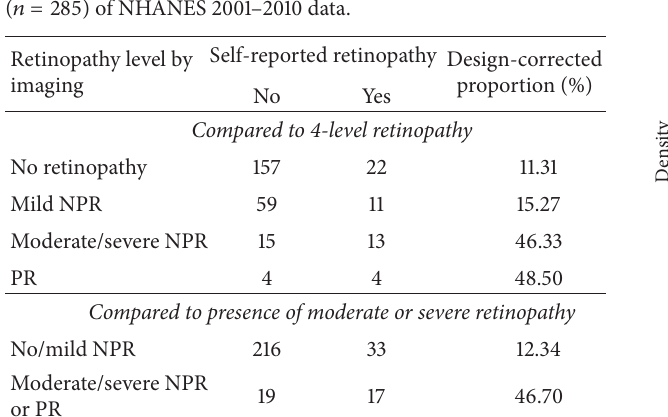
Table 4: Comparison of self-reported retinopathy in a subsample ( 𝑛 = 285 ) of NHANES 2001–2010 data.